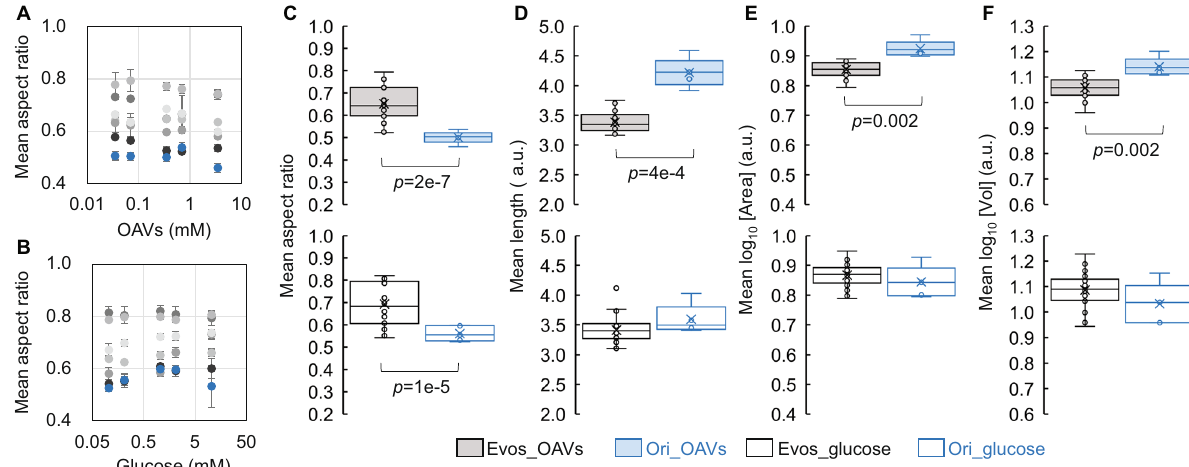
Fig. 4 Changes in cell shape and cell size. The cell shape, represented by the mean aspect ratio, in the presence of OAVs ( A ) or glucose ( B ) is shown. The Ori and Evos are indicated as blue and colourless circles, respectively. The grey circles (gradation from light to dark grey) indicate the six lineages. Standard errors of biological repeats ( N > 5) are indicated. The boxplots of the mean aspect ratio, the mean cell length, the mean logarithmic area, and the volume of the cell populations are shown in ( C – F ), respectively. The individual tests are indicated as circles, which correspond to the data in Supplementary Fig. 4. The medians and the averages of the growth rates are represented as lines and crosses inside the box, respectively. Statistical signi fi cance is indicated as the p- value. The meaning of the colour variation is